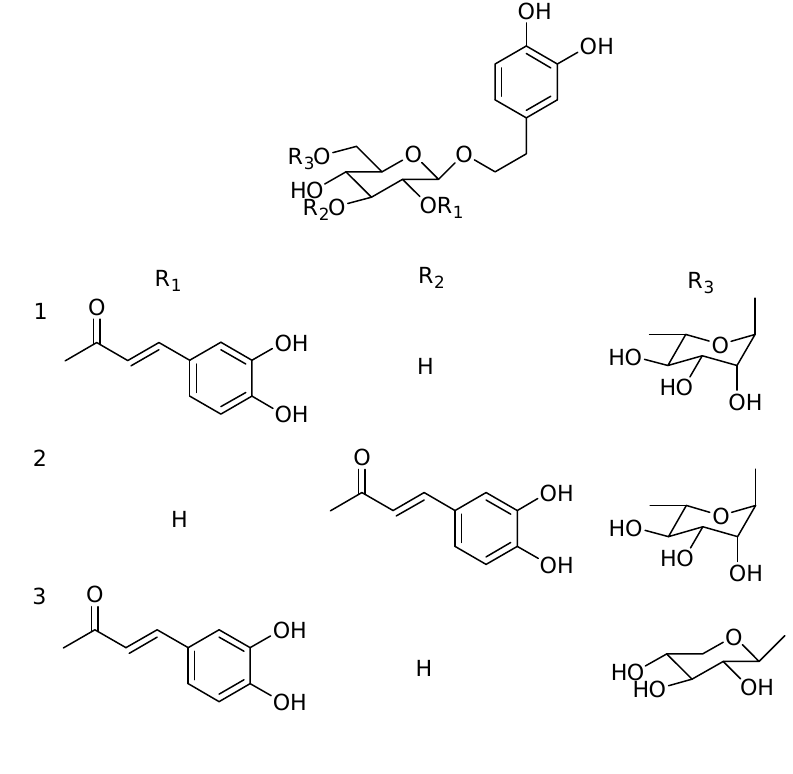
Figure 1. Structures of Forsythoside H ( 1 ), Forsythoside I ( 2 ) and Forsythoside J ( 3